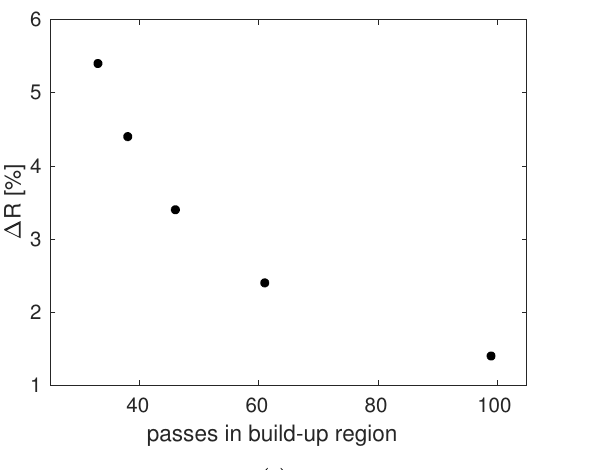
Figure 7. ( a ) In this plot, the number of passes needed to reach steady-state as function of reflectivity change, ∆ R = R build up − R equil , is shown. We assume that the build-up process is over when the energy modulation is at least A = 7. − ( b ) Example of ∆ R = 3.4%. For the first 46 passes the reflectivity is set to R build the reflectivity drops to R equil = 10.6% and the net gain is zero. As a result, the peak power is